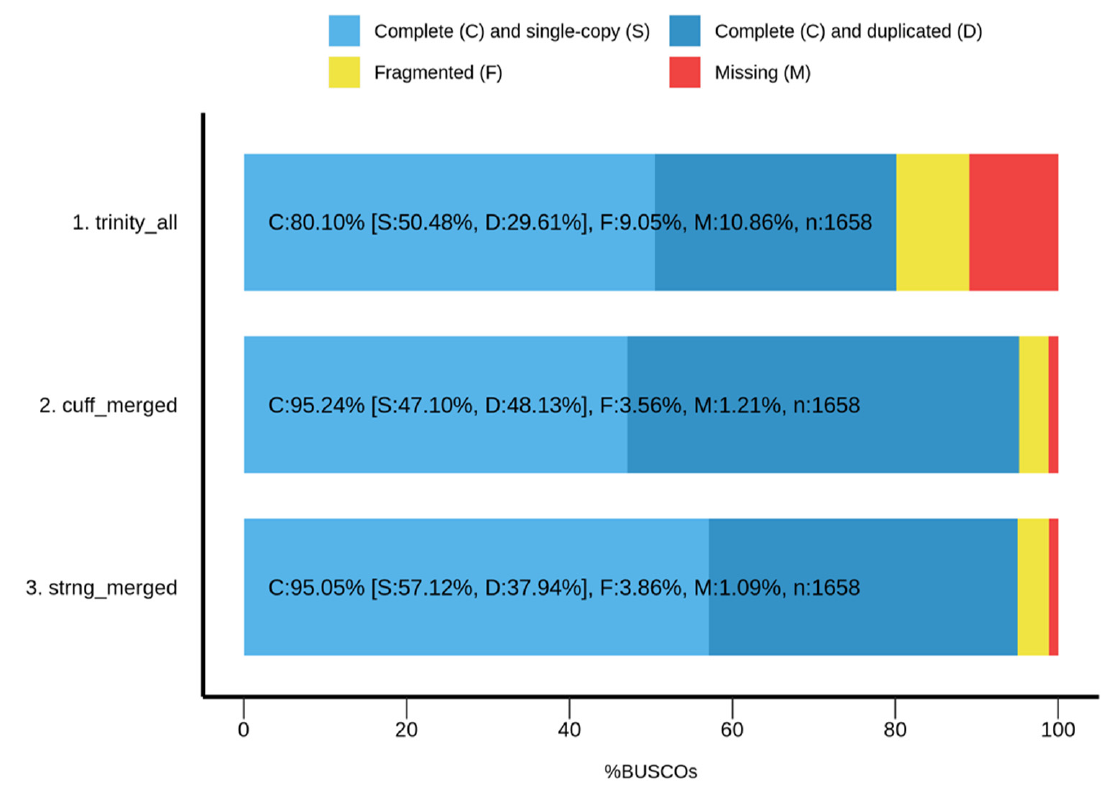
Figure 5. Measure of completeness of transcriptome assemblies from Bombyx mori strains using BUSCO (dataset: insecta_odb9).